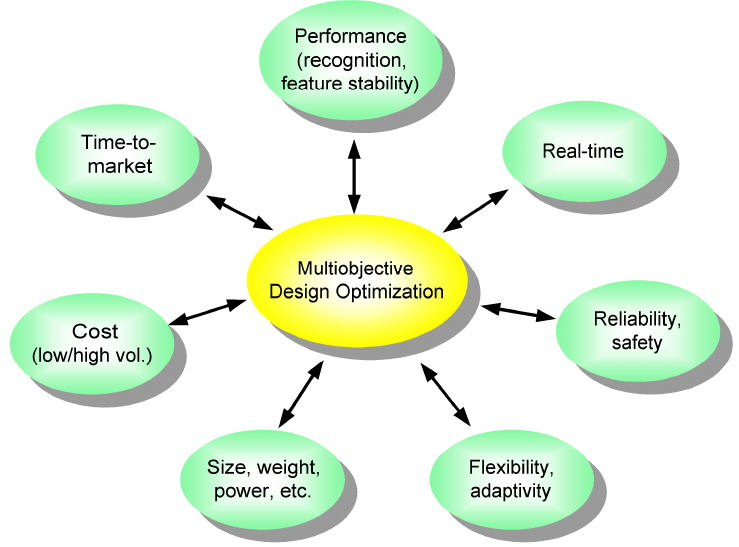
Figure 4. Objectives and constraints to be considered in designing of intelligent multi-sensor